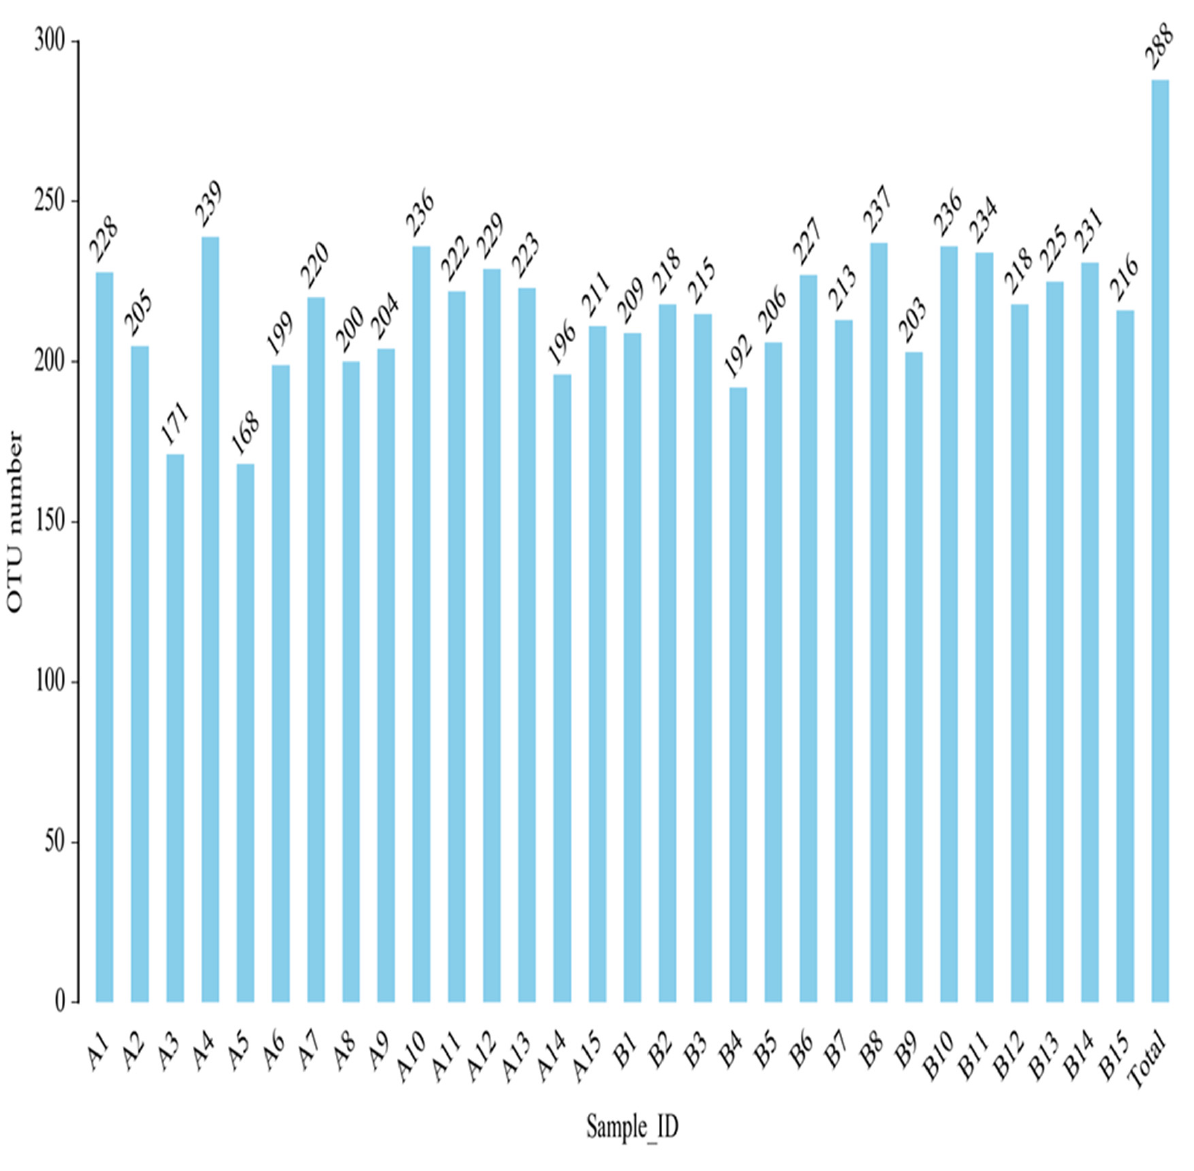
Figure 16. Histogram of OTU quantity of fecal intestinal flora of each sample after clustering. Table 6. The statistical table of species in different grades of